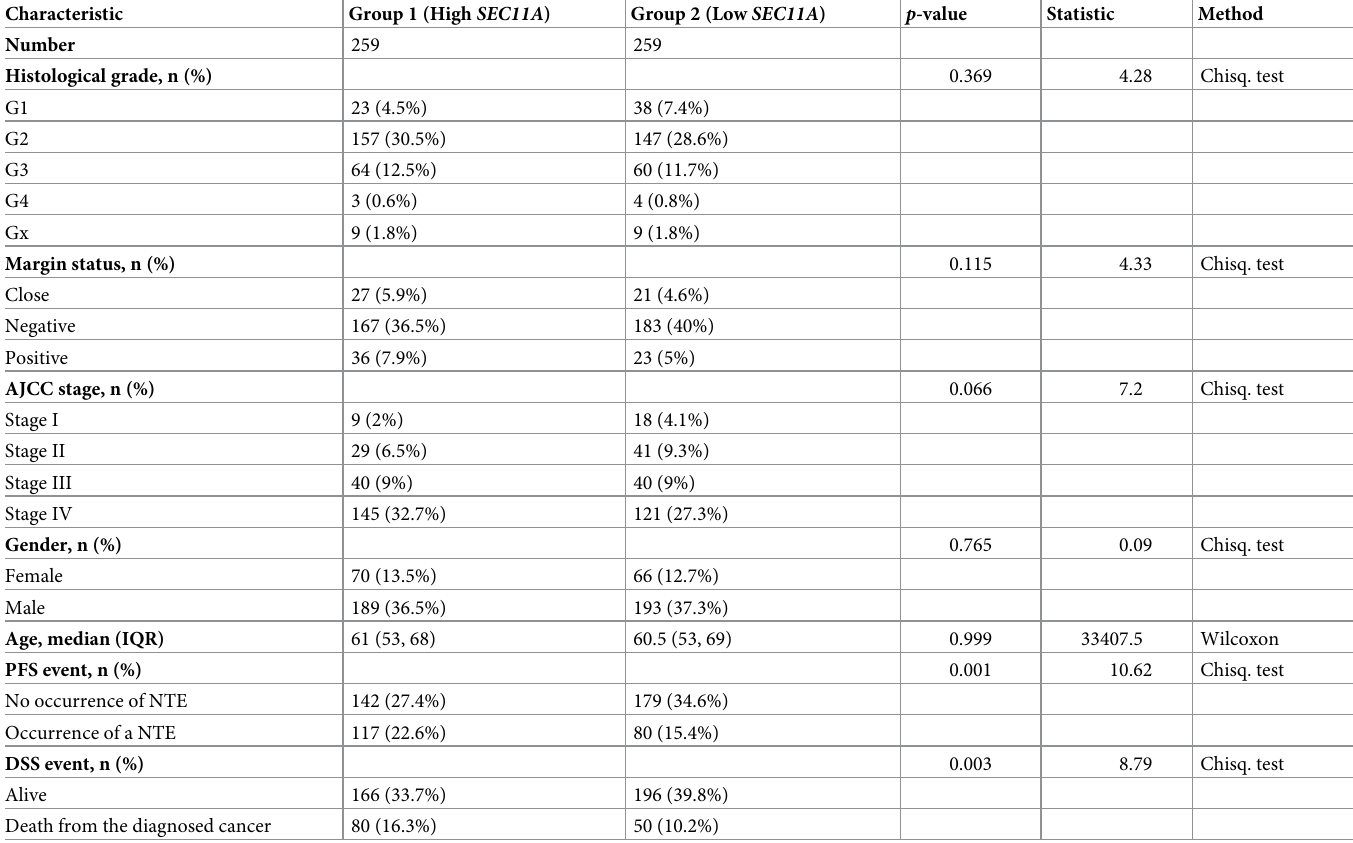
Table 1. Comparison of clinicopathological characteristics between high and low SEC11A expression